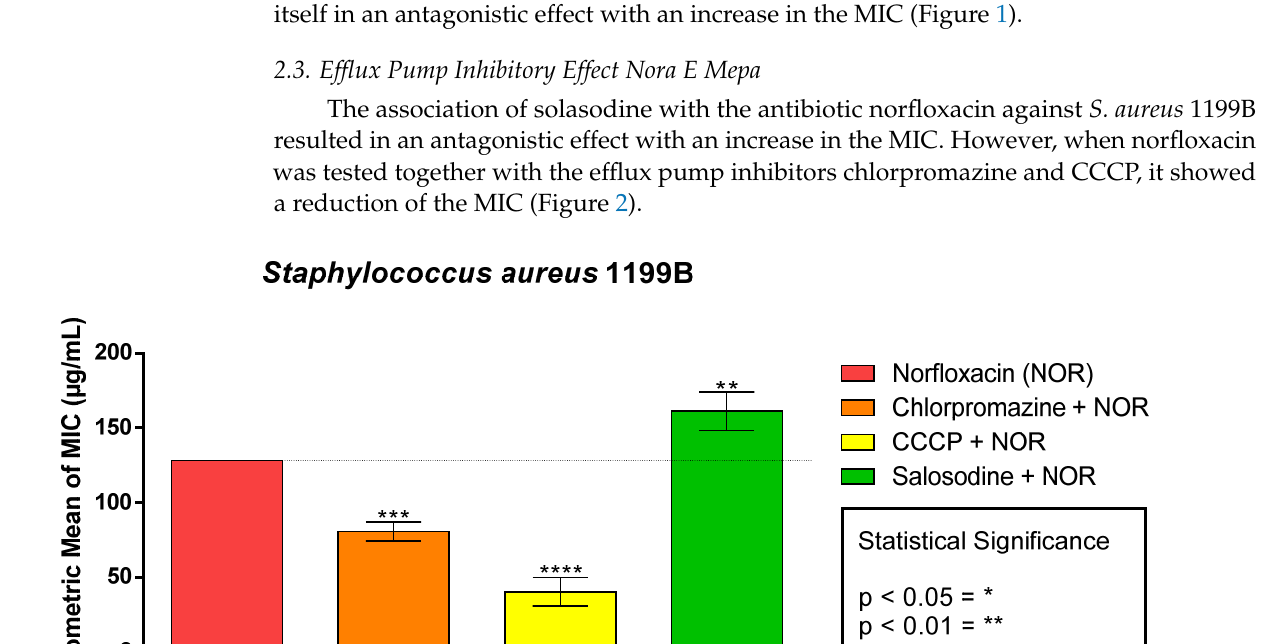
Figure 3. Modifying effect of ethidium bromide by solasodine on S. aureus strain 1199B. The association of solasodine with the antibiotic ciprofloxacin against S. aureus K2068 demonstrated antibiotic potentiation with a reduction in the MIC from 64 μ g/mL to 40 μ g/mL. It also resulted in a reduction in the MIC of ciprofloxacin when tested in conjunc- tion with the efflux pump inhibitors (Figure 4). This suggests that solasodine may be act- ing on the mechanism of action of the antibiotic, increasing its effect against the bacteria tested.